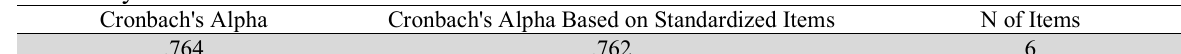
Reliability Test